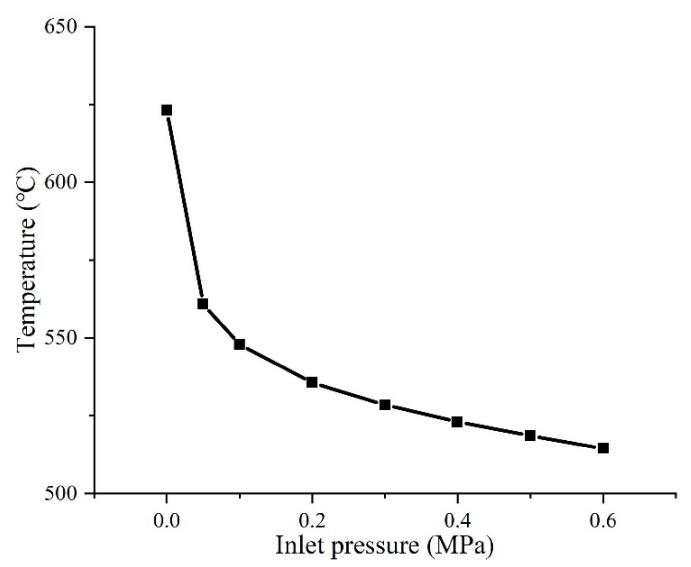
Figure 9. Maximum temperatures of tool under different inlet